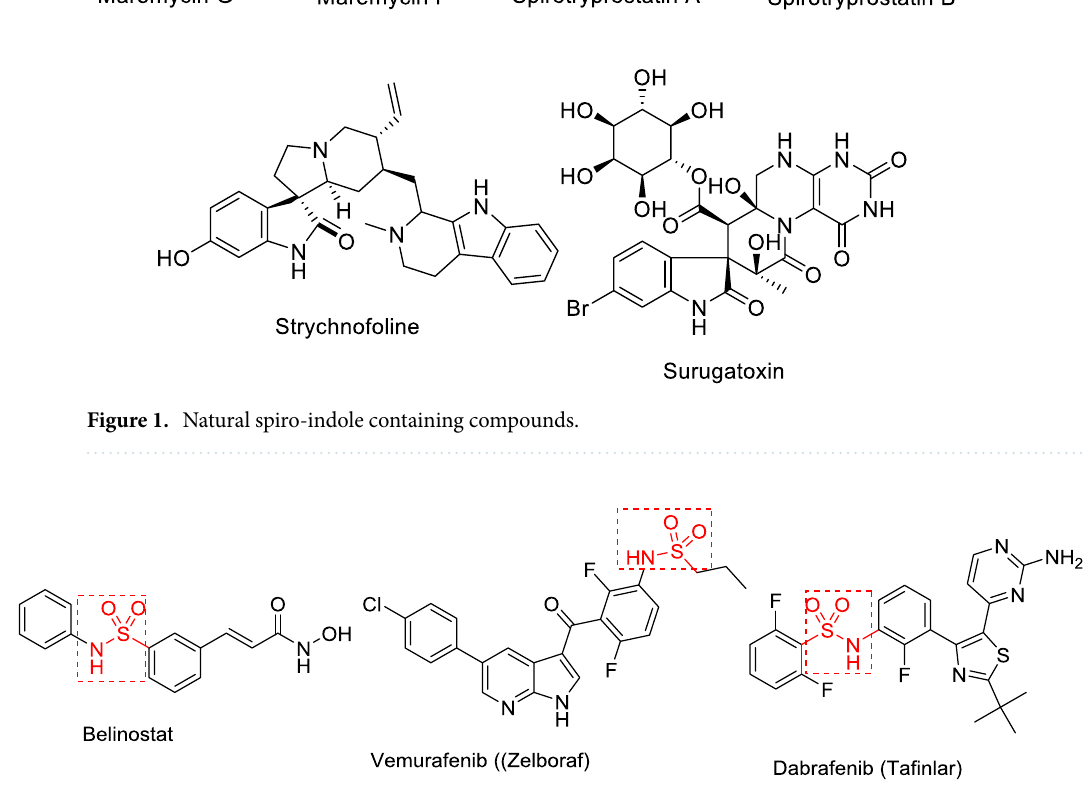
Figure 2. Approved antitumor sulfonamide-containing